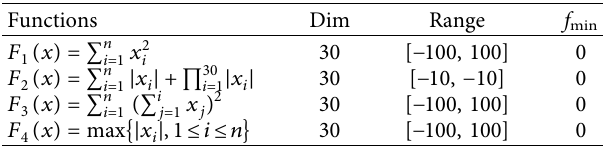
Table 1: Te benchmark functions.